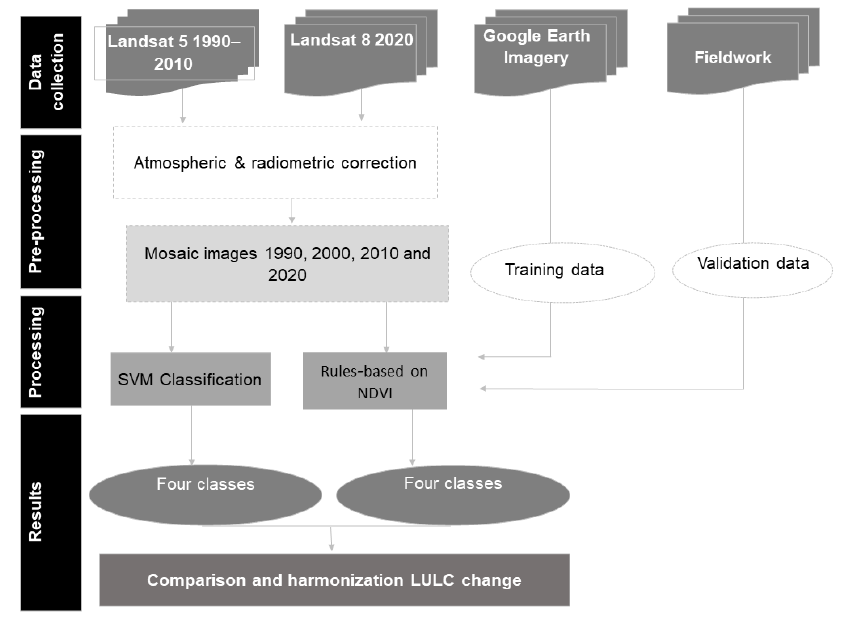
Figure 2. Work flow employed in our study of land use land cover changes in the High Atlas Mountains of Morocco.